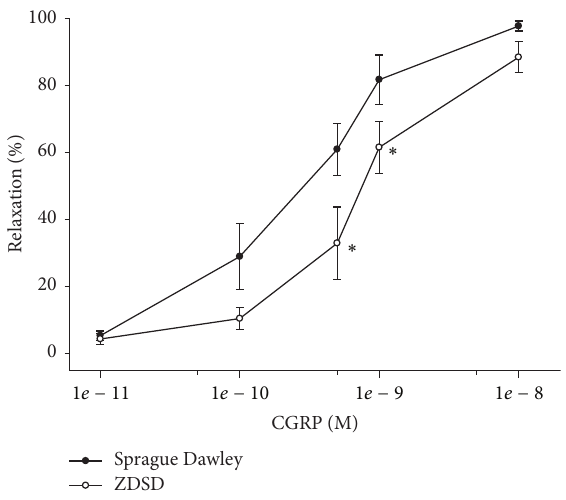
Figure 6: Vascular relaxation by calcitonin gene-related peptide in epineurial arterioles from age-matched Sprague Dawley and ZDSD rats. Arterioles were treated as described in Figure 5. Incremental doses of calcitonin gene-related peptide (CGRP) were added to the bathing solution while recording steady state vessel diameter. Data are presented as the mean of % relaxation ± S.E.M. The number of rats in each group was 10 and 9 for Sprague Dawley and ZDSD, respectively. ∗ 𝑃 < 0.05 compared to Sprague Dawley